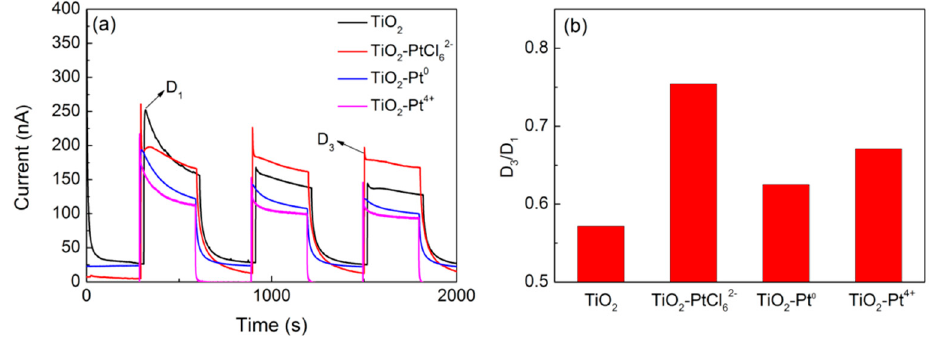
Figure 8. ( a ) Photocurrents of TiO 2 , TiO 2 -Pt 0 , TiO 2 -PtCl 62- and TiO 2 -Pt 4+ ; and ( b ) maximum